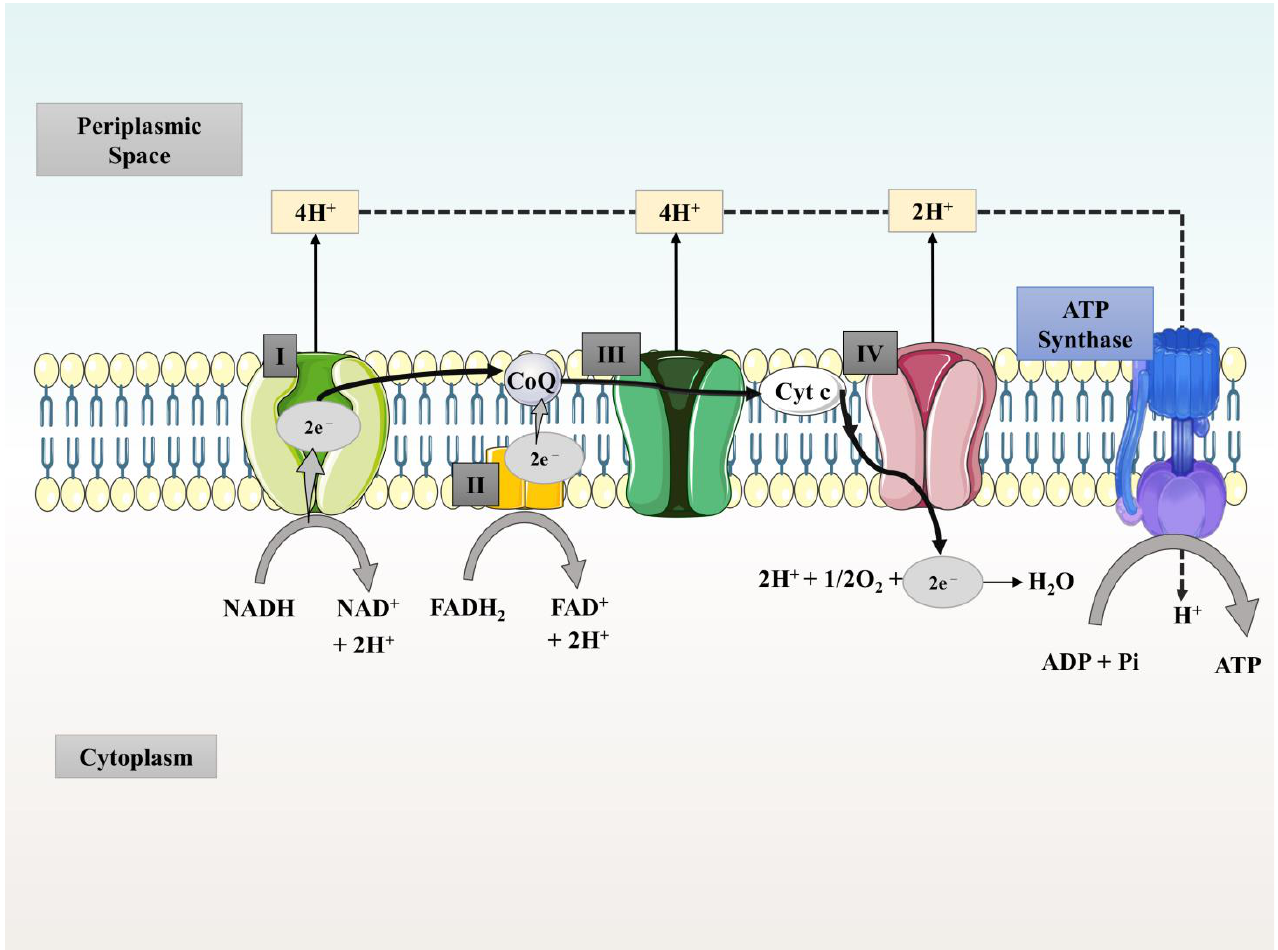
Figure 2. Mechanism of electron transport in the plasma membrane.